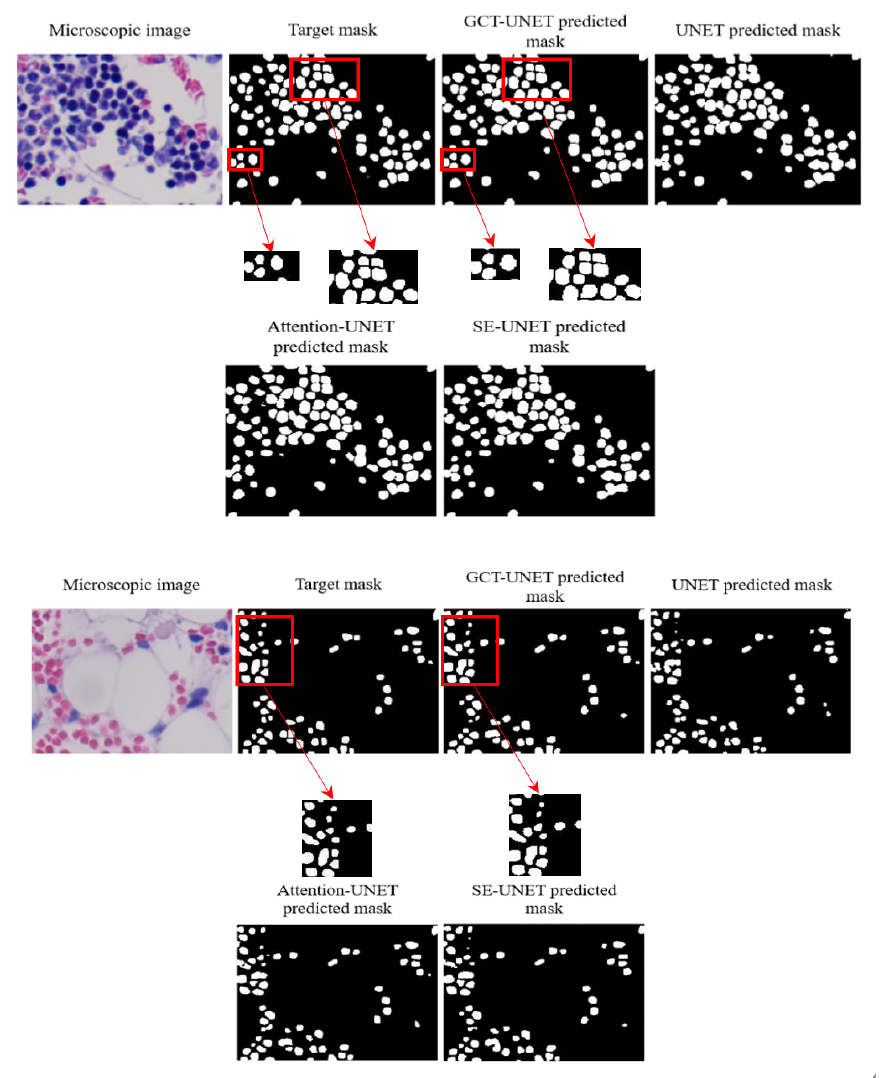
Figure 4. Compare the segmentation results of different